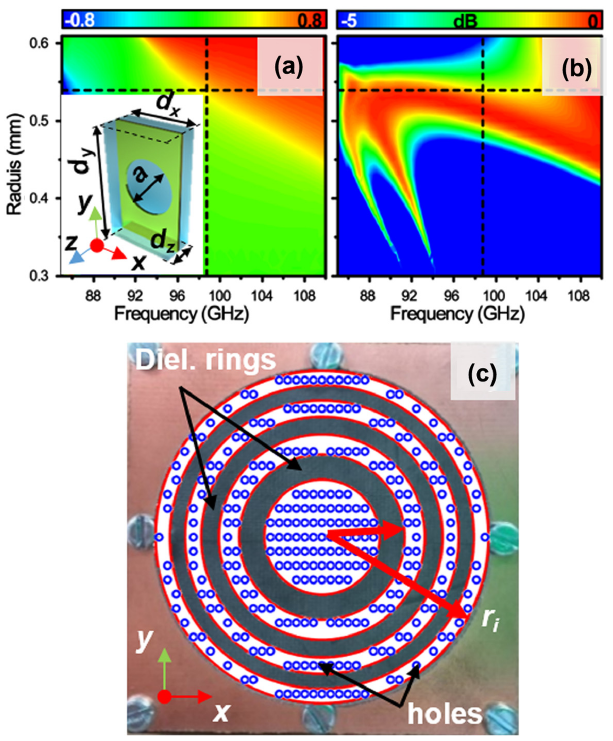
Figure 1. (a) Equivalent refractive index, n f , for a fishnet metama- terial made of four plates. Vertical and horizontal black dashed lines correspond to the working frequency f 0 = 99 GHz and hole diameter a = 0.54 respectively. Parameter definition of fishnet metamaterial unit cell (Inset); (b) Transmission coefficient S 21 for a four-plate fishnet metamaterial; (c) Fabricated WZP fishnet metamaterial lens and its seven Fresnel